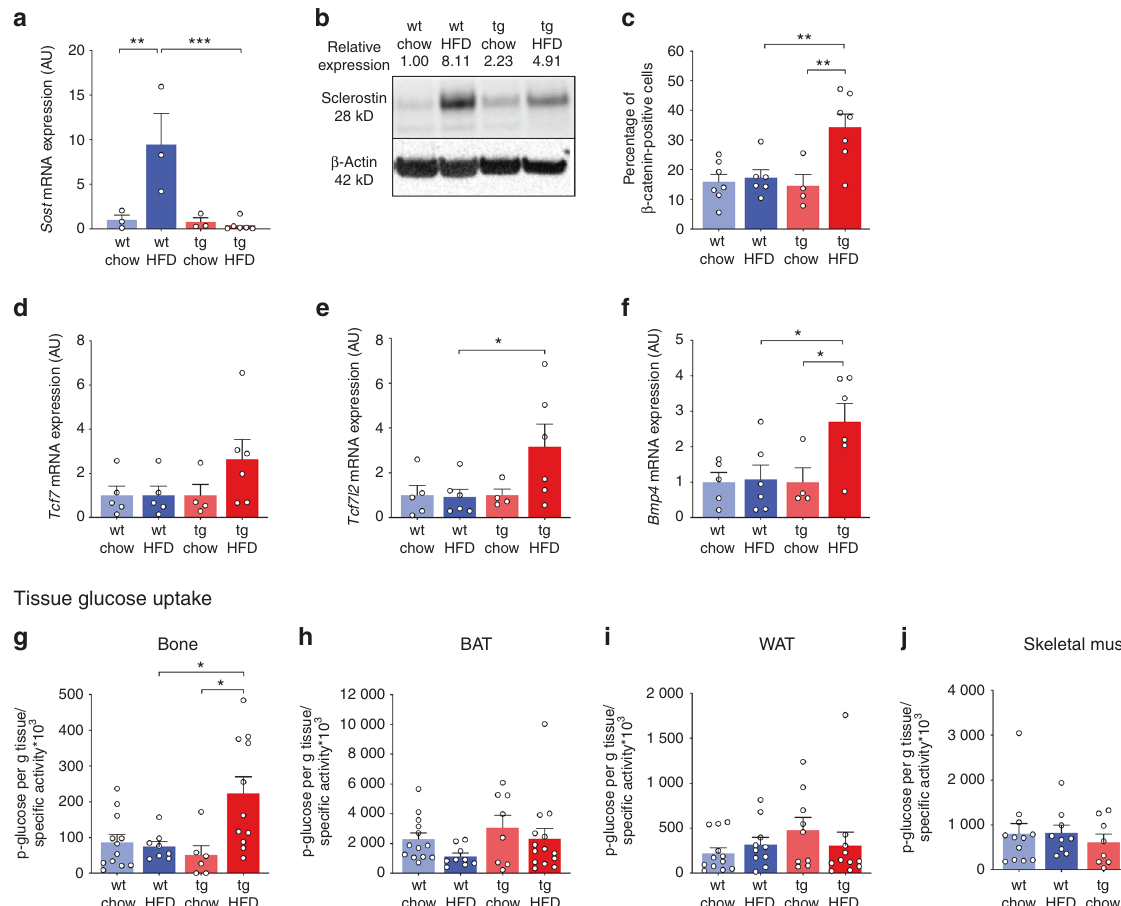
Fig. 4 Wnt signaling and glucose uptake in the bones of wild-type and HSD2 OB/OCY -tg mice. The results are shown as scatterplots, with the mean ± SEM shown in columns. a Bone expression of sclerostin ( Sost ) mRNA. All mRNA expression results are shown relative to chow-fed wild- type mice and are expressed in arbitrary units (AU), normalized to 18S mRNA expression. The diet × genotype interaction was highly signi fi cant ( F 1,11 = 9.71, P = 0.009 8). b Immunoblot of sclerostin protein expression in bones of wild-type and HSD2 OB/OCY -tg mice: each lane contains samples pooled from three mice, with β -actin shown as a loading control. c Proportion of β -catenin-positive osteoblasts and osteocytes. The diet × genotype interaction was signi fi cant ( F 1,20 = 6.488, P = 0.019). Representative sections of trabecular bone from each group of mice are shown in Fig. S2. d – f Bone mRNA expression of the Wnt signaling molecules d transcription factor 7 (T-cell speci fi c, HMG-box) ( Tcf7 ), e transcription factor 7 like 2 ( Tcf7l2 ), and f bone morphogenetic protein-4 ( Bmp4 ). g Glucose uptake into bone; h brown adipose tissue; i gonadal white adipose tissue; and j quadriceps muscle after 8 weeks of chow/FHD deeding. For glucose uptake measurements, n = 6 – 14 for each group. For glucose uptake in bone, the effect of genotype was signi fi cant ( F 1,33 = 4.729, P = 0.037). Signi fi cance was determined using two-way ANOVA, with the Tukey ’ s multiple comparison test used for post hoc testing. In all cases, * P < 0.05, ** P < 0.01, and *** P < 0.001 for mice compared to wild-type mice: 18 weeks of HFD feeding feeding, both wild-type and transgenic mice developed fasting increased fat mass in wild-type mice by 63% ( P < 0.000 1 vs. chow) hyperglycemia (Fig. 6). When fed a HFD, insulin resistance but only by 30% in transgenic mice ( P = 0.054 vs. chow, Fig. 7c). In developed in wild-type mice but not in HSD2 OB/OCY -tg mice wild-type mice, fat accumulation occurred mostly in gonadal (Fig. 6d). Fasting insulinemia was not affected by diet or genotype (central) fat, which was increased 2.5-fold in mass by HFD feeding (Fig. S3). Wild-type mice, but not HSD2 OB/OCY -tg mice, also ( P < 0.000 1 vs. chow, Fig. 7d). In HSD2 OB/OCY -tg mice, however, developed impaired glucose tolerance after 18 weeks of HFD feeding (Fig. 6g, h). HFD feeding did not signi fi cantly increase gonadal fat mass (68% increase, P = 0.44 vs. chow). Consistent with the differences in HSD2 OB/OCY -tg mice were protected against HFD-induced obesity body fat accumulation, HFD feeding was accompanied by increased serum leptin concentrations in wild-type but not and dyslipidemia transgenic mice (diet × genotype interaction: P = 0.042, Fig. 7e). We also analyzed the changes in the body weight and body To ascertain the cause of the differences in adiposity, we composition of wild-type and HSD2 OB/OCY -tg mice in response to measured food intake and energy expenditure. In both wild-type HFD feeding. As in our previous studies, 19,26 the initial body and transgenic mice, cumulative caloric intake was signi fi cantly weight was ~4 g lower in HSD2 OB/OCY -tg mice than in wild-type increased upon HFD feeding but was not different between mice (effect of genotype, F 1,56 = 34.46, P < 0.000 1, Fig. 7a). genotypes (Fig. 7f). HFD feeding led to a signi fi cant increase in Regardless of their starting weights, the effects of HFD feeding on energy expenditure in HSD2 OB/OCY -tg mice ( P < 0.05 for each body weight and adiposity were attenuated in HSD2 OB/OCY -tg